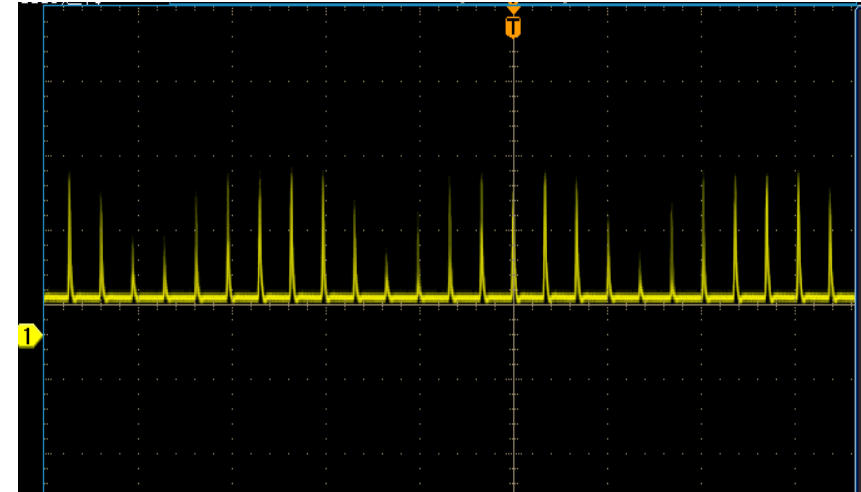
Figure 3. Oscilloscope trace of the double-pass amplified pulse train.